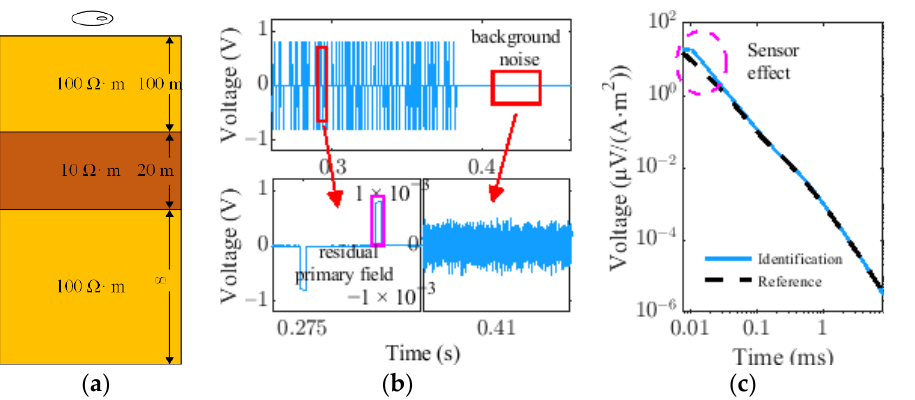
Figure 12. ( a ) Layered earth model. ( b ) 1-D Synthetic EM data which contains residual primary field and gaussian noise. ( c ) Comparison of the reference impulse response and identified model impulse response obtained by correlation identification method.